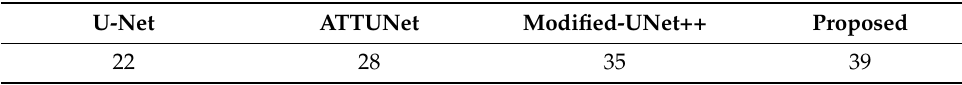
Table 8. Inference runtime comparison (unit: ms).